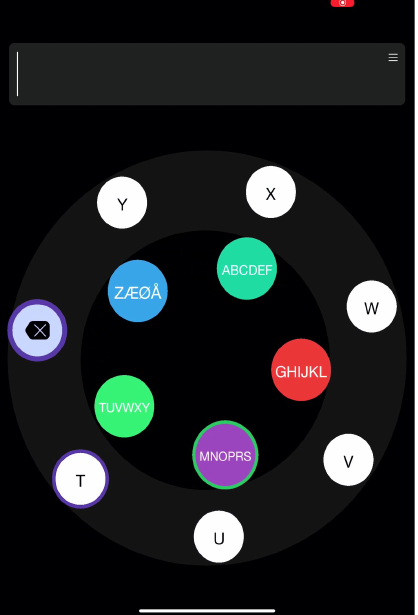
Figure 1. The EyeTell application, with five targets circulating clockwise in the inner circle and seven targets circulating counter-clockwise in the outer circle. The outer circle has the individual letters from T,U,V,W,X and Y, which indicates that the cluster TUVWXY (green target from the inner circle) was selected